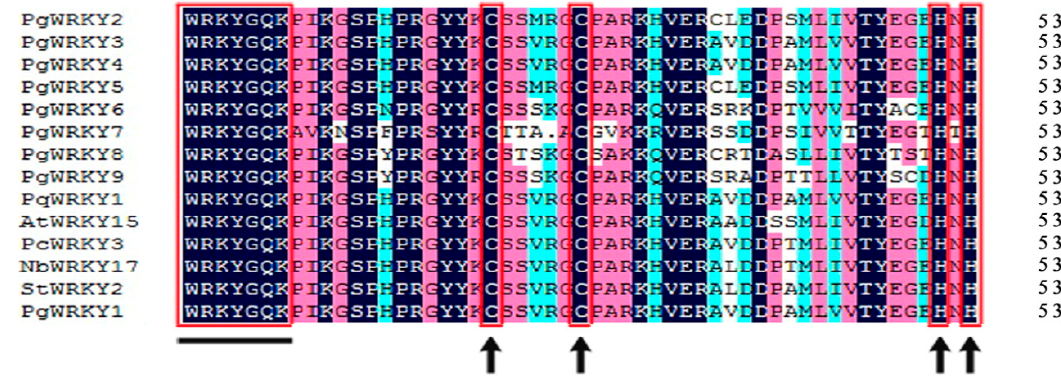
Figure 2. WRKY domain comparison of the eight analyzed PgWRKY TFs (PgWRKY2-9) with other members of WRKY Group II. Amino acid sequence analysis of the eight PgWRKYs with P. quinquefolius PqWRKY1 (AEQ29014.1), A. thaliana AtWRKY15 (AEC07442.1), Petroselinum crispum PcWRKY3 (AAC49528.1), Nicotiana benthamiana NbWRKY17 (AIR74899.1), Solanum tuberosum StWRKY2 (NP_001275001.1), and P. ginseng PgWRKY1 (KR060074) was accomplished using DNAMAN software. The WRKYGQK sequence motifs are underlined and cysteines (C) and histidines (H) in the zinc-finger motifs are indicated by arrowheads.